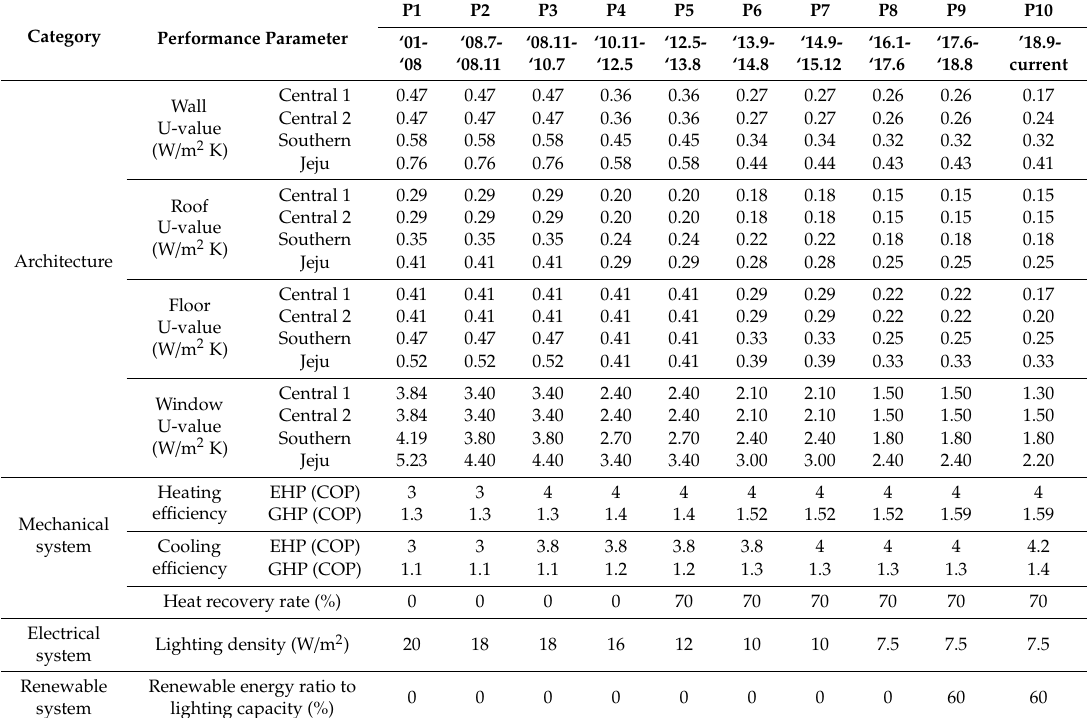
Table 7. Values of performance parameters according to the reinforcement of the prescriptive criteria. Category